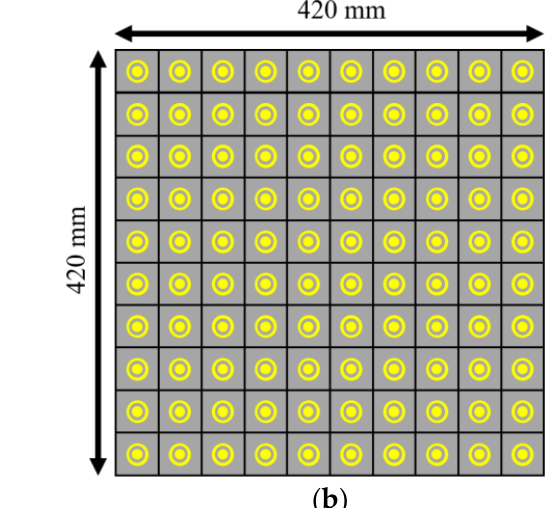
Figure 7. 10×10-unit cells array ( a ) circular type patch ( b ) circular type patch with a ring.